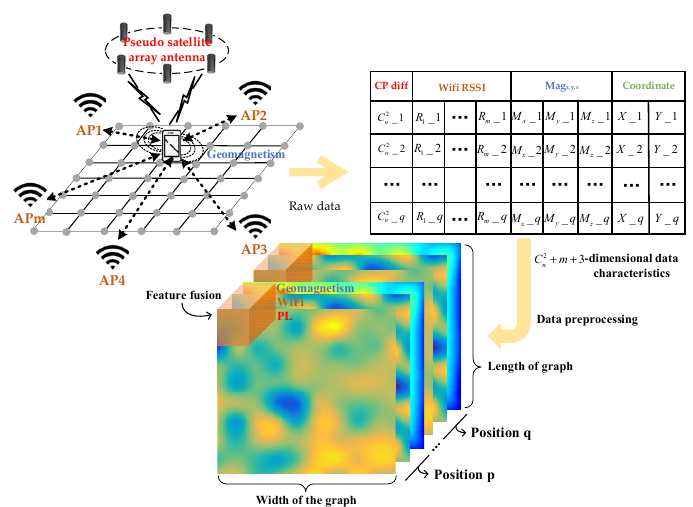
Figure 7. Construction method of multi-dimensional electromagnetic atlas.